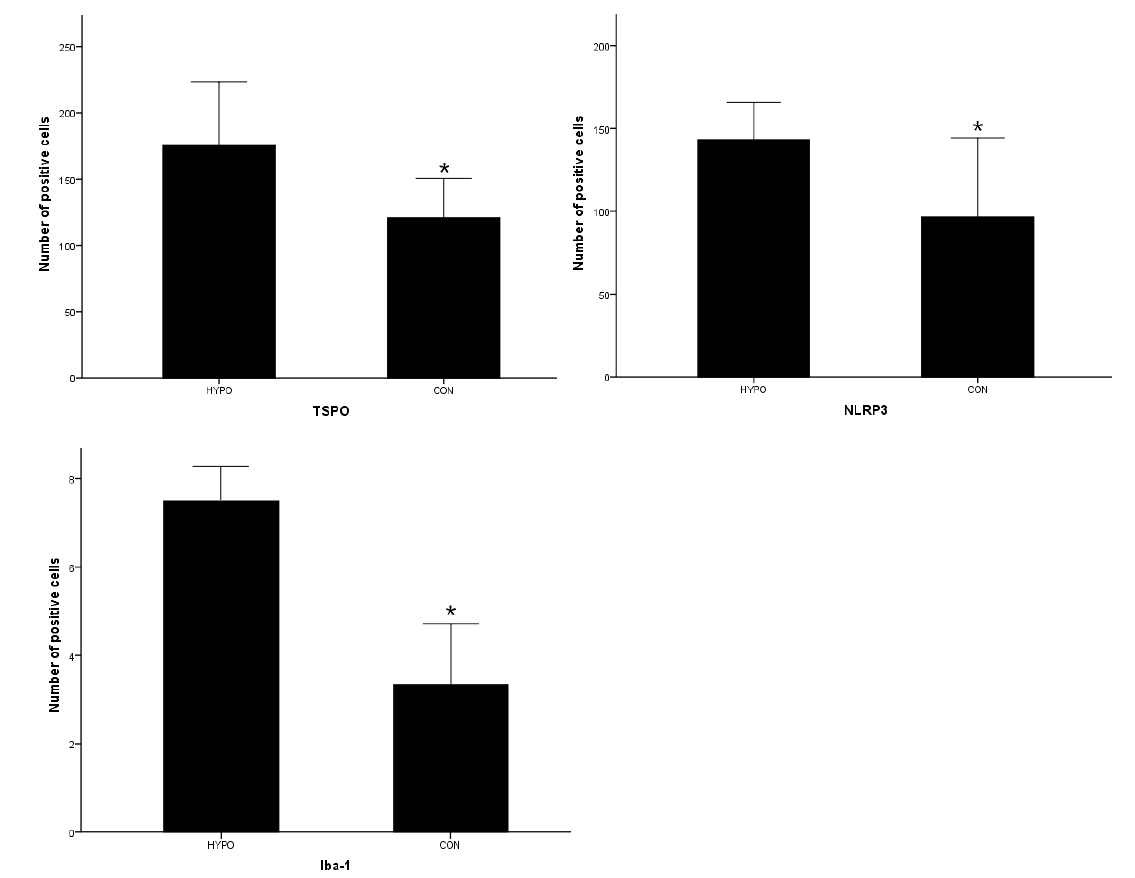
Figure 6. Quantitative analysis of immunohistochemistry positive cells (* p < 0.05).